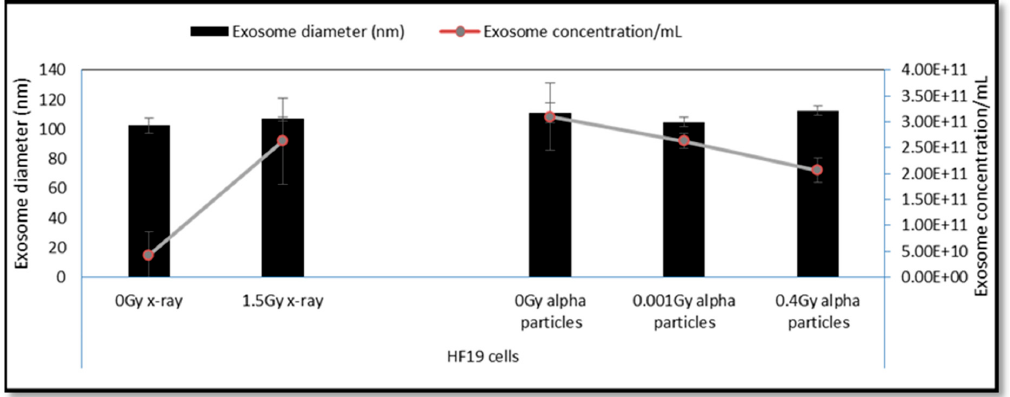
Figure 5. Exosome characterisation 24 h following direct x-ray and alpha-particle irradiation. A significant increase in exosome concentration was displayed by the 1.5 Gy x-ray-irradiated group compared to the corresponding control. However, a non-significant gradual decrease was observed by 0.001 Gy and 0.4 Gy alpha-particle-irradiated groups compared to the corresponding control. The data showed a non-significant change in the size of the exosomes for all ir- radiated groups compared to the corresponding controls.